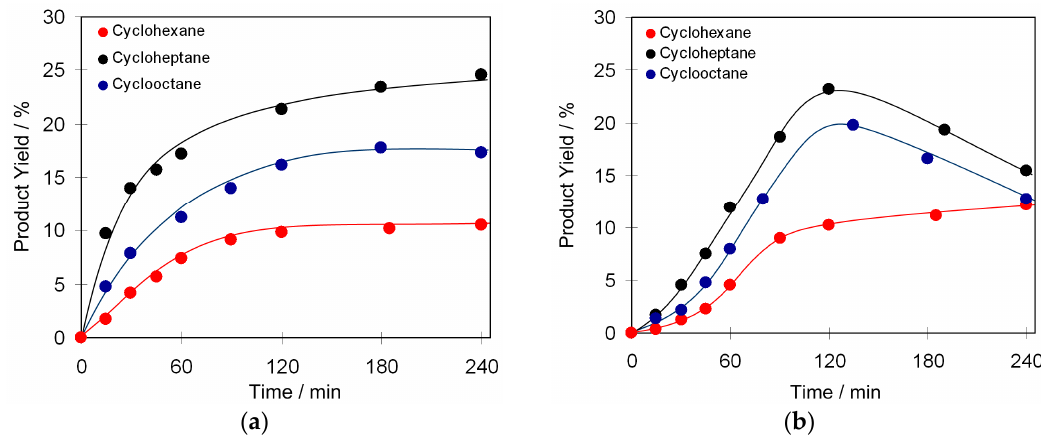
Figure 4. Mild oxidation of cycloalkanes (C 6 –C 8 ) to the corresponding alcohols and ketones (total yield) by H 2 O 2 catalyzed by 1 ( a ) and 2 ( b ). Reaction conditions are those of Figure 3.